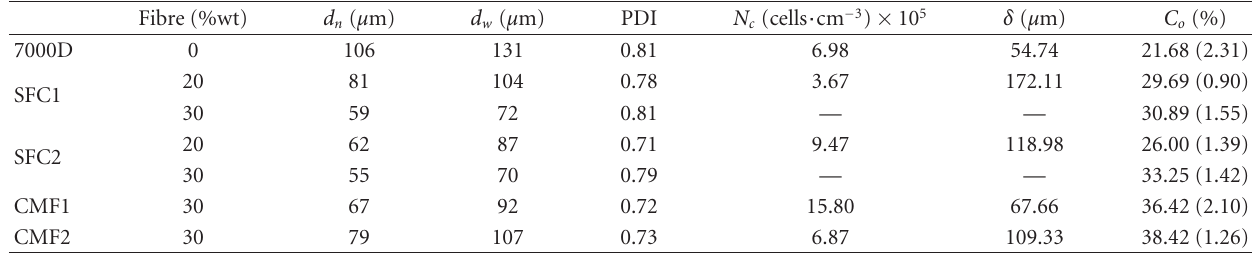
Table 16: Cell dimensions ( d n , d w ), cell density ( N c ), cell size polydispersity (PDI), cell-wall thickness ( δ ), and open-cell ratio ( C o ) as a function of the fibre nature and fibre content (PLA7000D, 3wt% CBA2 for biocomposites foams, 4wt% CBA2 for PLA foam, temperature profile A, screw speed 30 rpm, die temperature 195 ◦ C, free cooling)-( ): standard